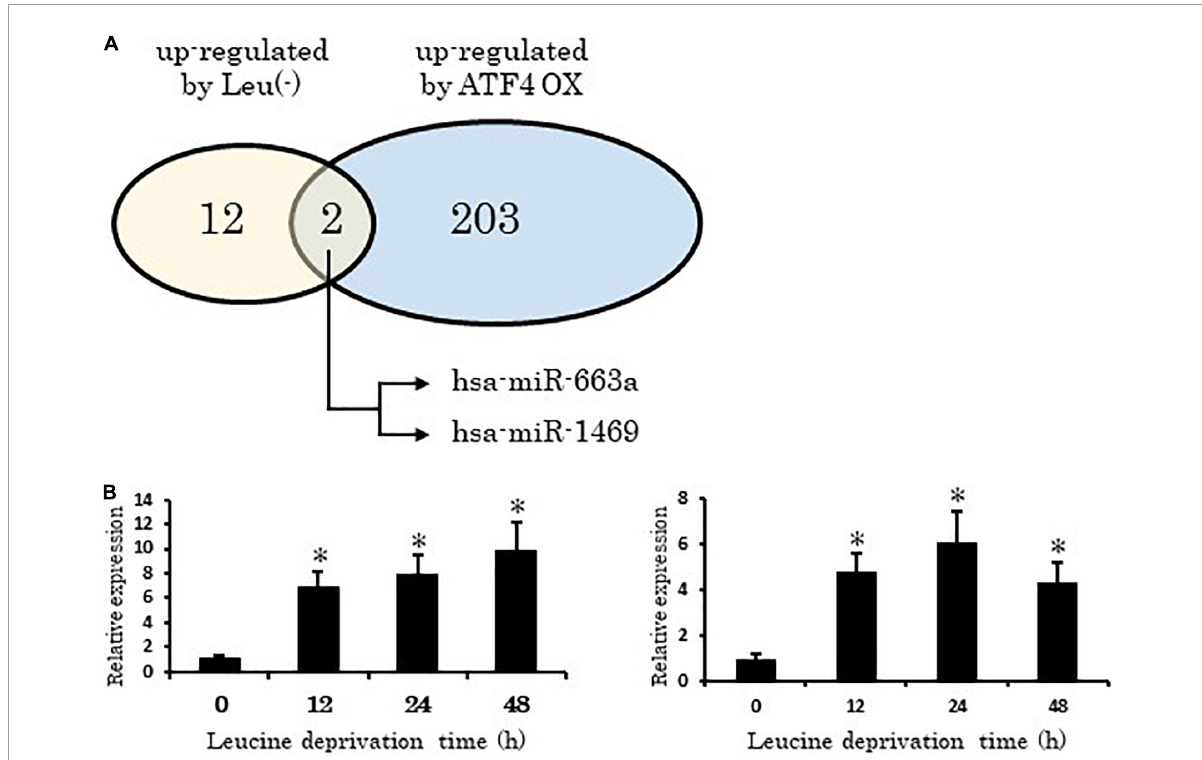
FIGURE1 Activating transcription factor 4 (ATF4) directly regulates microRNAs under leucine deprivation. (A) Two miRNAs, hsa-miR-663a and hsa-miR-1469, show increased expression in ATF4 overexpression and leucine deprivation experiments. (B) Time-course expression of hsa-miR-663a (left) and hsa-miR-1469 (right). Leu (-), leucine deprivation; ATF4 OX, activating transcription factor 4 overexpression. Data are shown as means ± standard error (SE) of three independent experiments. * p < 0.05 vs.